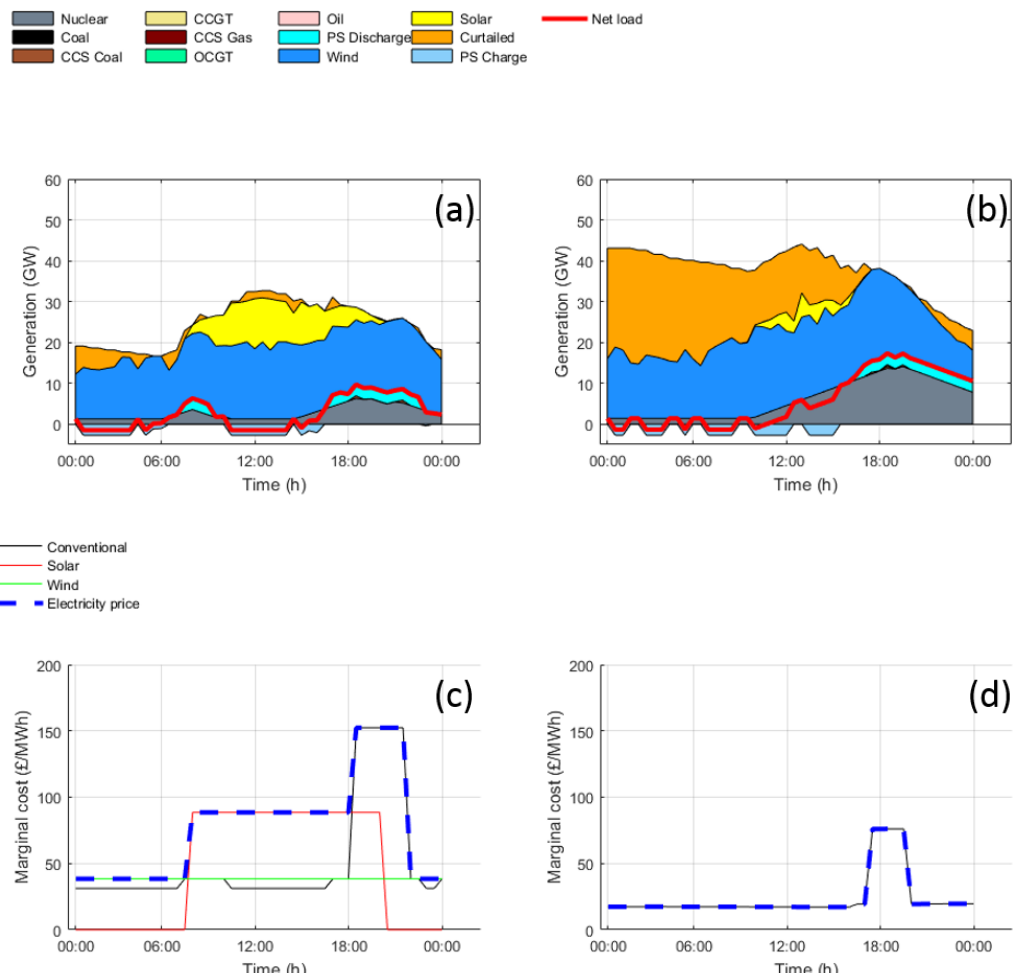
Figure 4. Analysis of electricity prices ( a ) Dispatch on a spring day in the long run electricity price regime ( b ) Dispatch on a winter day in the short run electricity price regime ( c ) Marginal costs on a spring day in the long run electricity price regime ( d ) Marginal costs on a winter day in the short run electricity price regime.